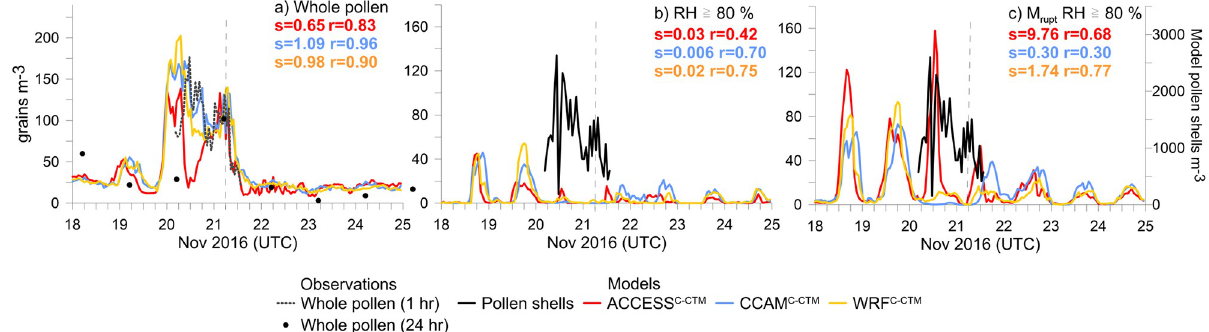
Fig 2. Time series in whole grass pollen (a) and pollen shells (b–c) from the RH � 80% experiment. Panel (b) shows results from in-atmosphere only pollen rupturing, whilst panel (c) includes the on-plant mechanical rupturing from Eqs 2–5. Model values in (c) are on second y-axes to the right. s = slope of the linear regression and r = r correlations between modelled and observed pollen (or pollen shells), given in same colours as the legend. Vertical dashed line indicates the time of the